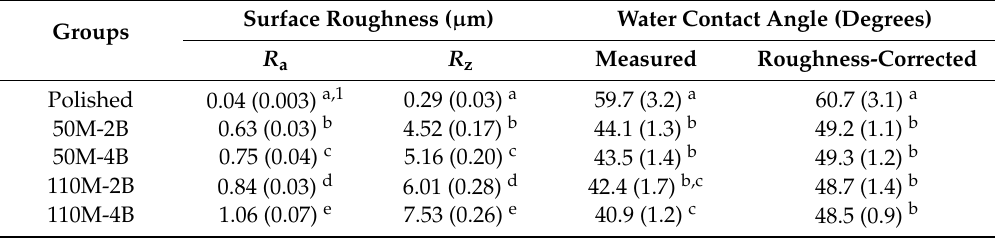
Table 1. Mean (standard deviation) surface roughness values and water contact angles for the polished and sandblasted